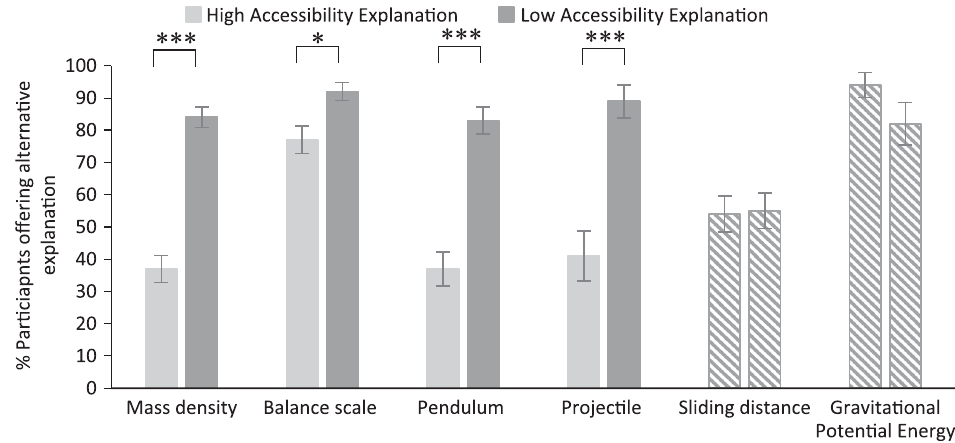
FIG. 1. Experiment 2 results for the short answer format: Percentages of participants who indicated alternative explanations may exist when presented with an explanatory factor with high or low accessibility. Hashed bars indicate scenarios in which experiment 1 determined no significant difference between the accessibilities of the